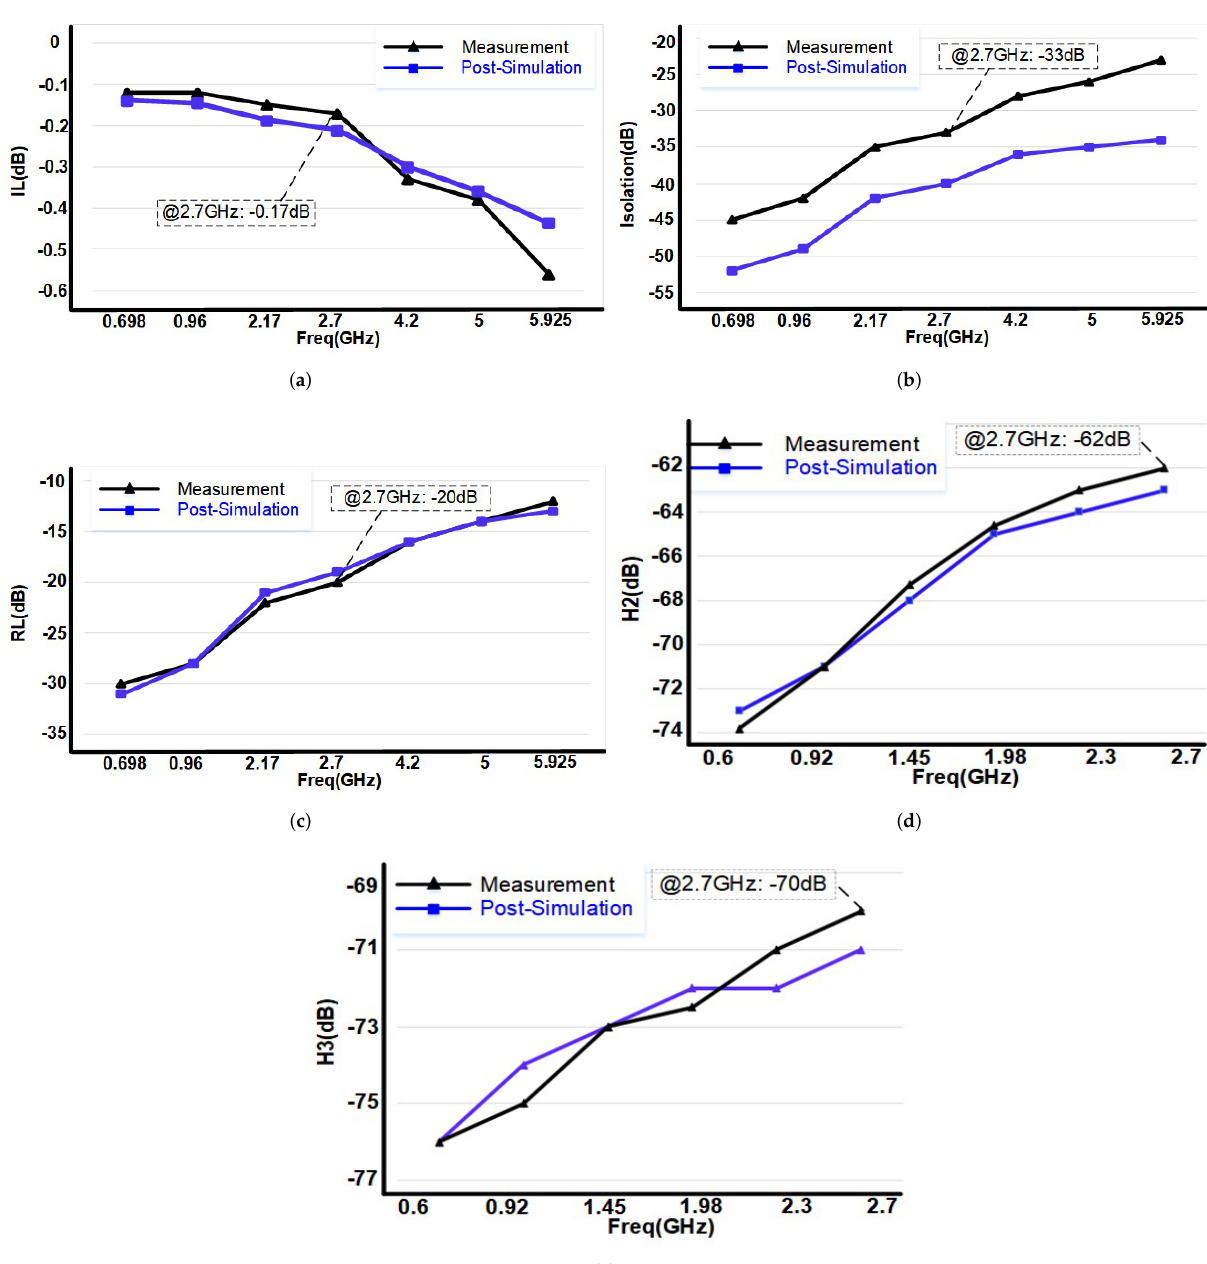
Figure 17. Measured and post-simulated ( a ) insertion loss, ( b ) isolation, ( c ) return loss, ( d ) second harmonic and ( e ) third